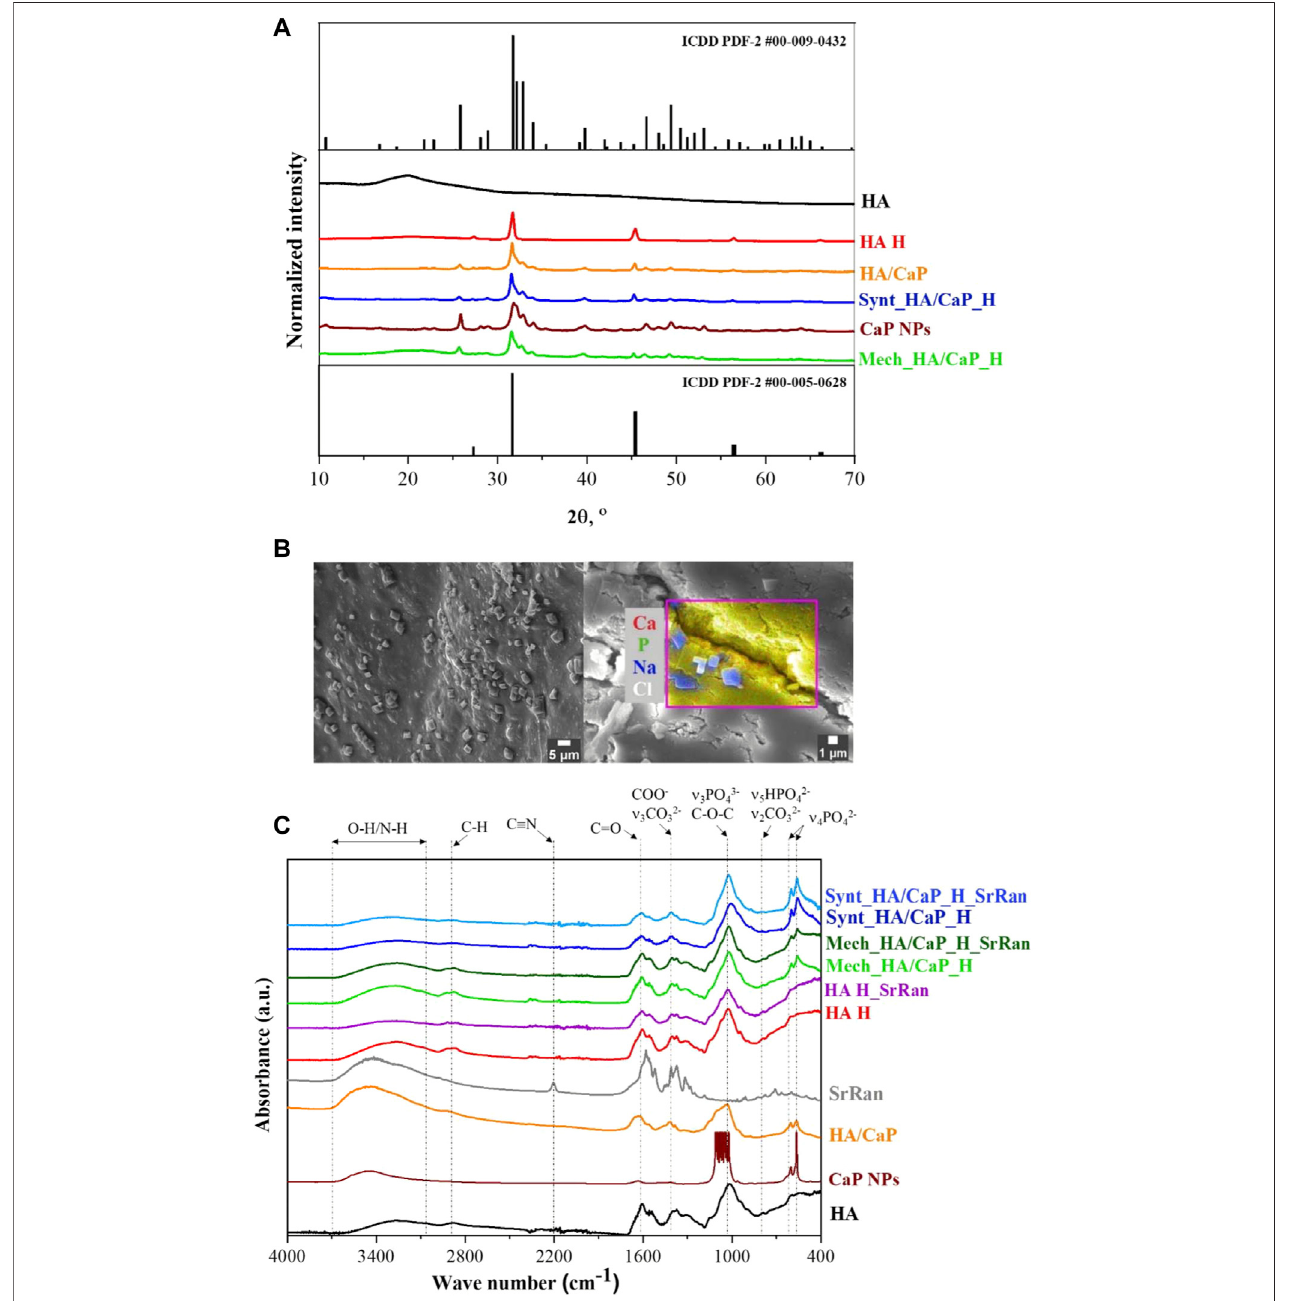
FIGURE 1 | Phase composition and molecular structure of prepared composites. (A) XRD patterns of raw materials and prepared lyophilized hydrogels; (B) SEM micrograph and EDS area analysis revealing NaCl crystals on the surface of Mech_HA/CaP_H sample; (C) FT-IR spectrum.